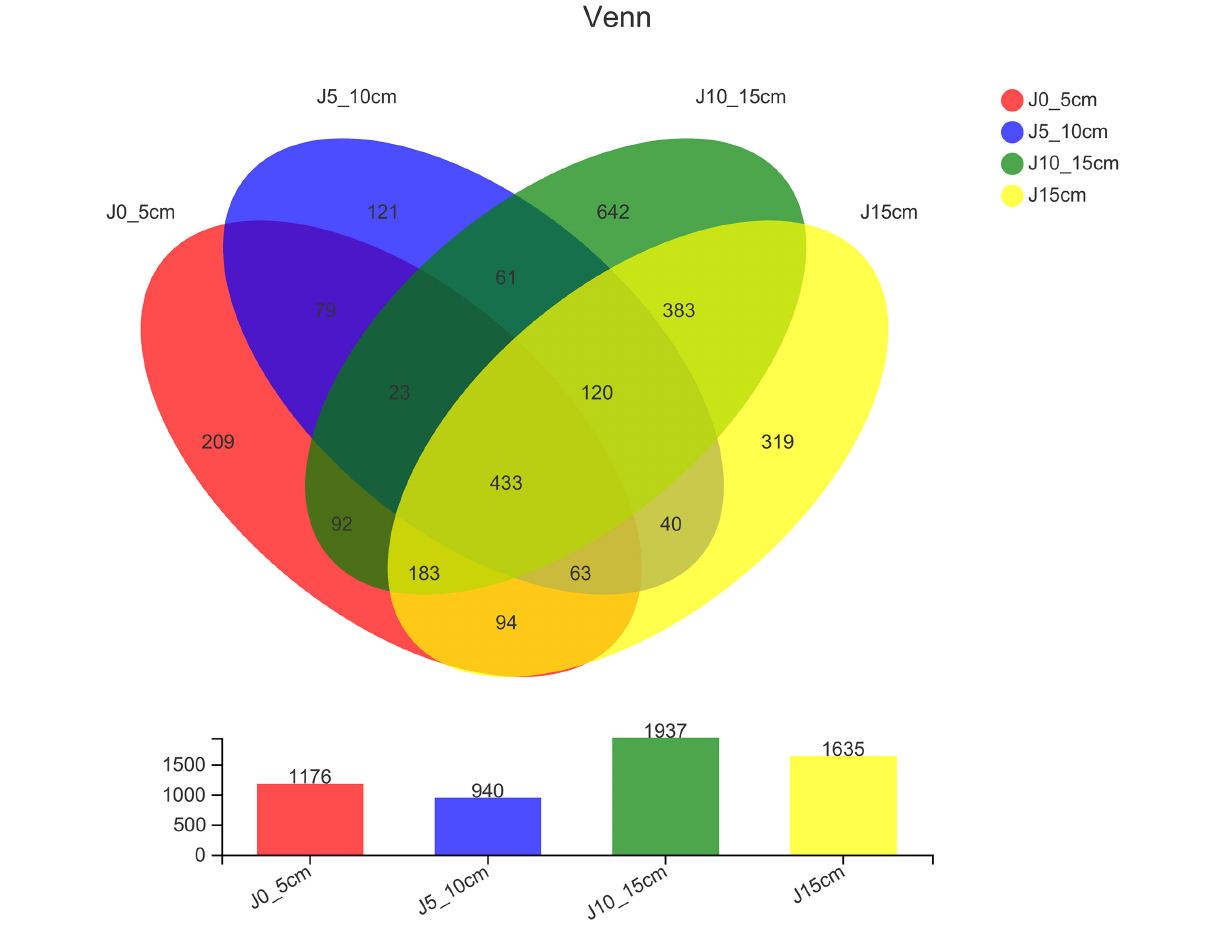
FIGURE 2 | Venn diagrams showing number of OTUs shared and unique among different samples (group J0_5cm represents length of stems was from 0 to 5 cm; group J5_10cm represents length of stems was from 5 to 10 cm; group J10_15cm represents length of stems was from 10 to 15 cm; group J15cm represents length of stems was longer than 15